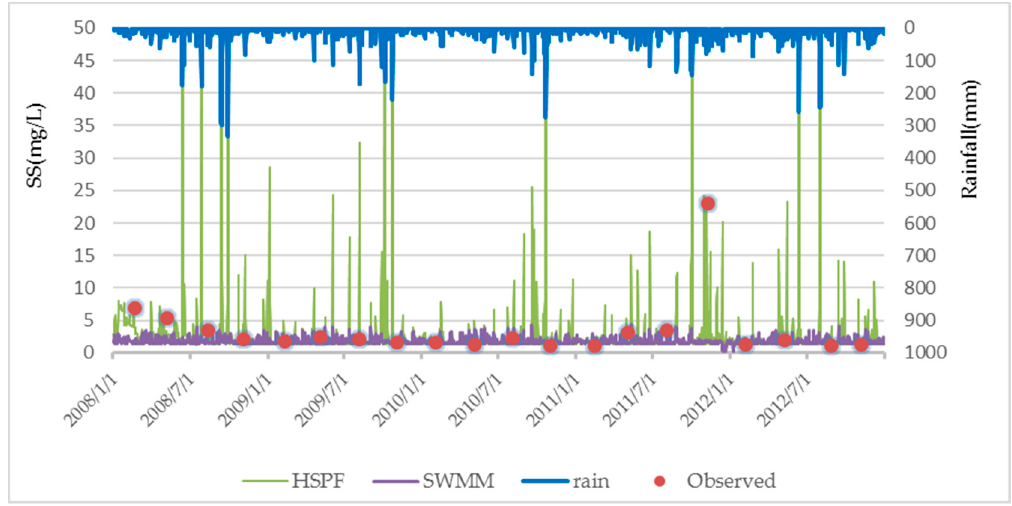
Figure 9. SS concentrations obtained from the HSPF and SWMM simulations and observations. Water 2017 , 9 , 780